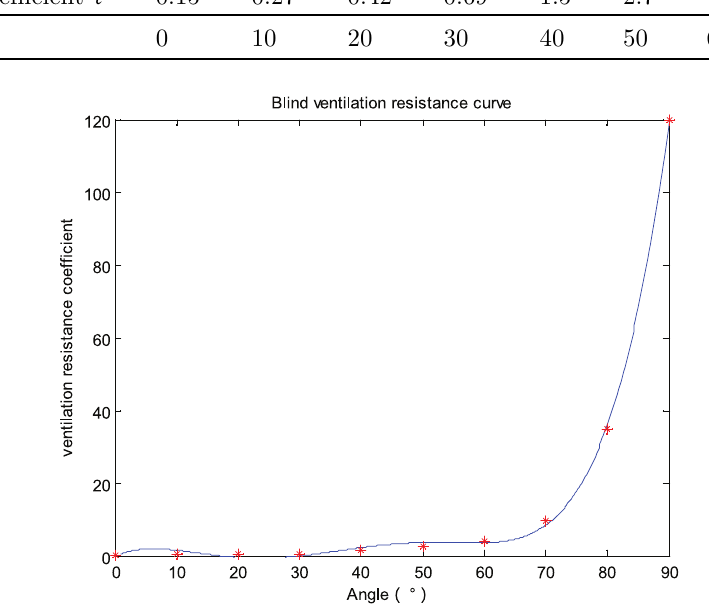
Table 1. The corresponding table of the ventilation resistance coef fi cient and the blade angle data of the rotary vane air door Ventilation resistance coef fi cient t